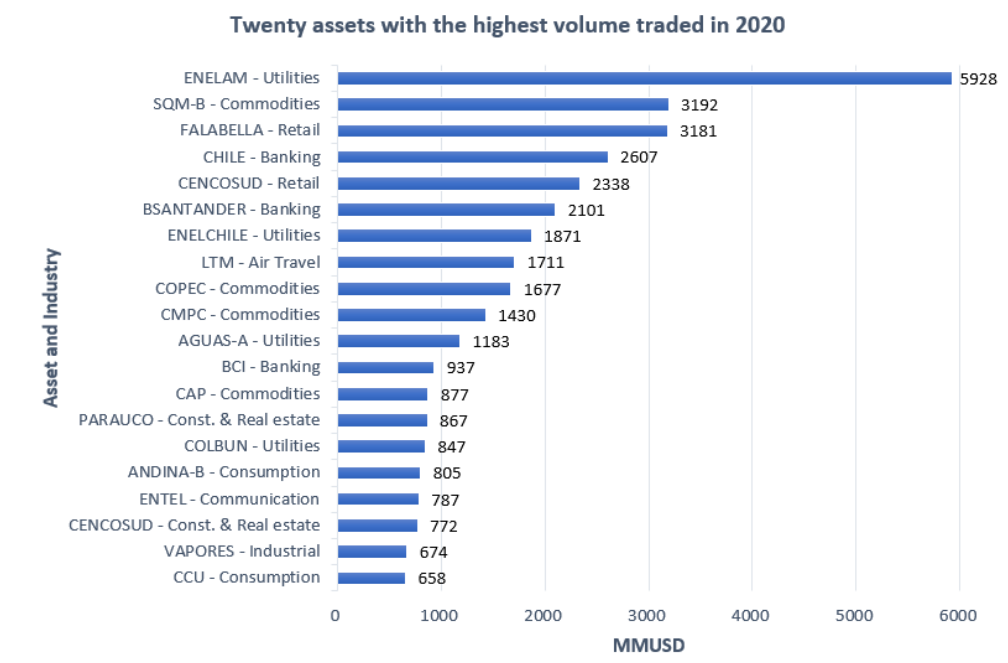
Figure 2. Amount of 20 most traded shares in 2020, shown by industry. Source: Authors’ own elaboration.